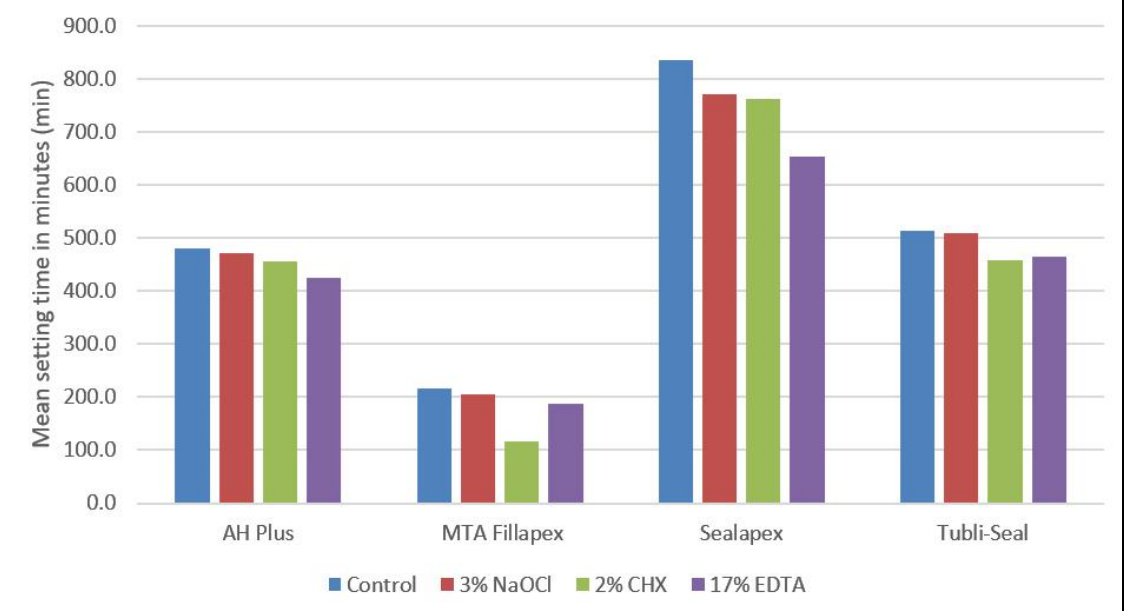
Figure 2. Bar chart denoting the mean setting time of different base endodontic sealers (AH Plus, MTA Fillapex, Sealapex, Tubli-Seal) on interaction with different endodontic irrigants (3% NaOCl, 2% CHX, and 17% EDTA) and distilled water.